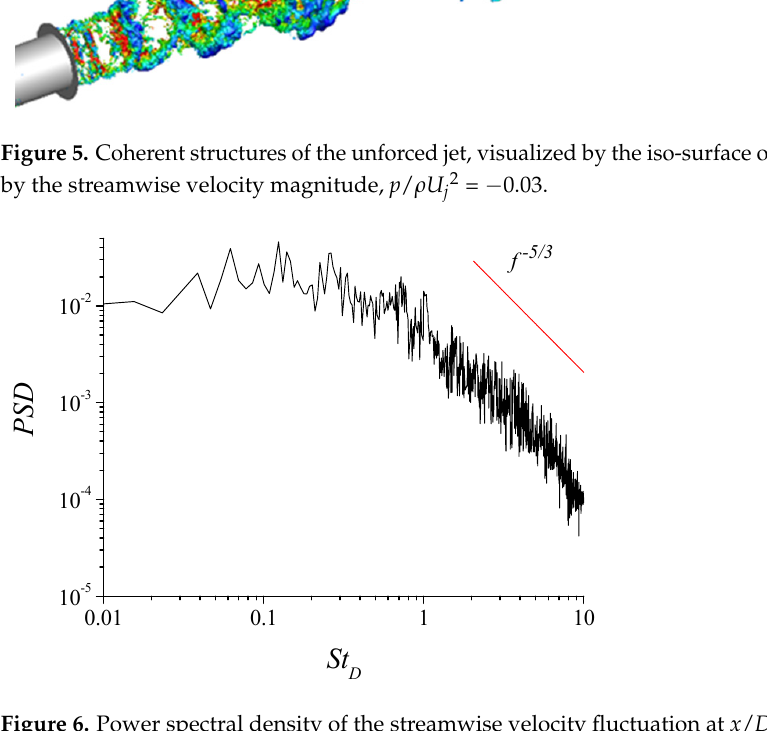
Figure 6. Power spectral density of the streamwise velocity fluctuation at x / D = 1, y / D = 0.5.